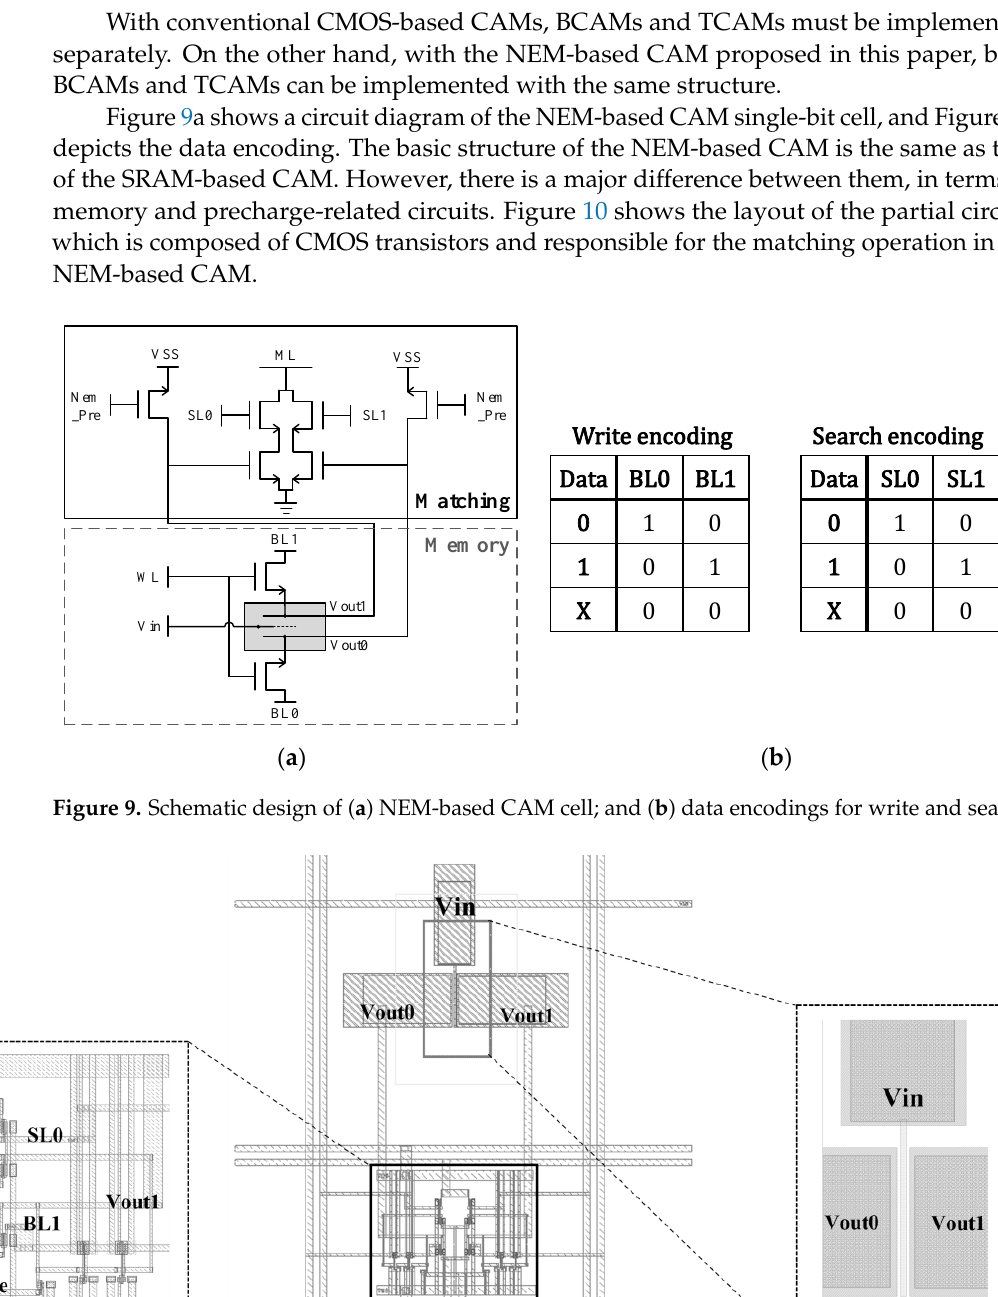
Figure 8. Schematic of a nanoelectromechanical (NEM) memory cell. NEM-Based CAM